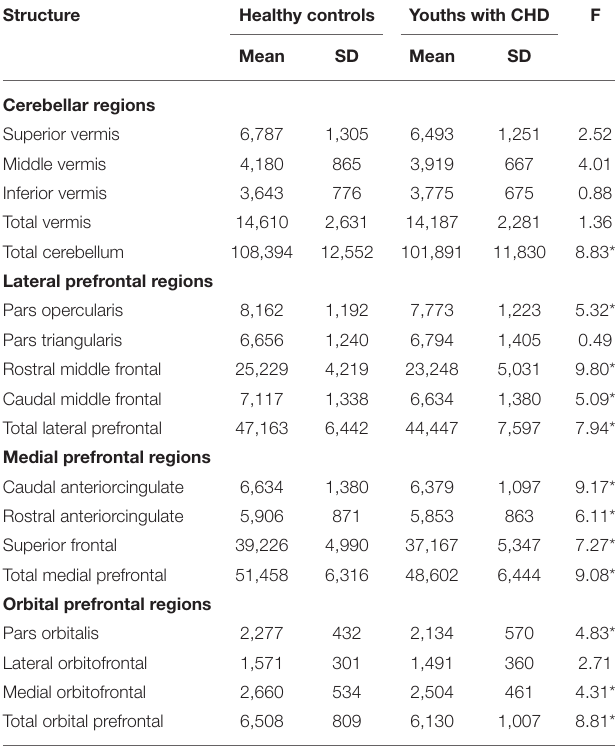
TABLE 1 | Demographic differences between youth with CHD and healthy controls. Healthy controls Youths with CHD